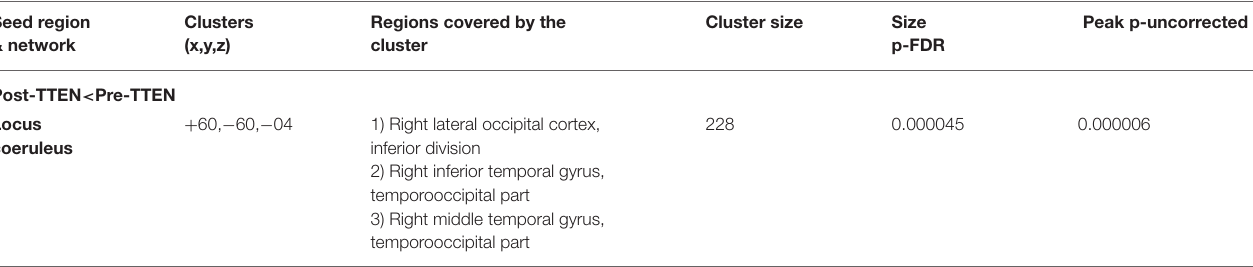
Cluster size Size Peak p-uncorrected p-FDR